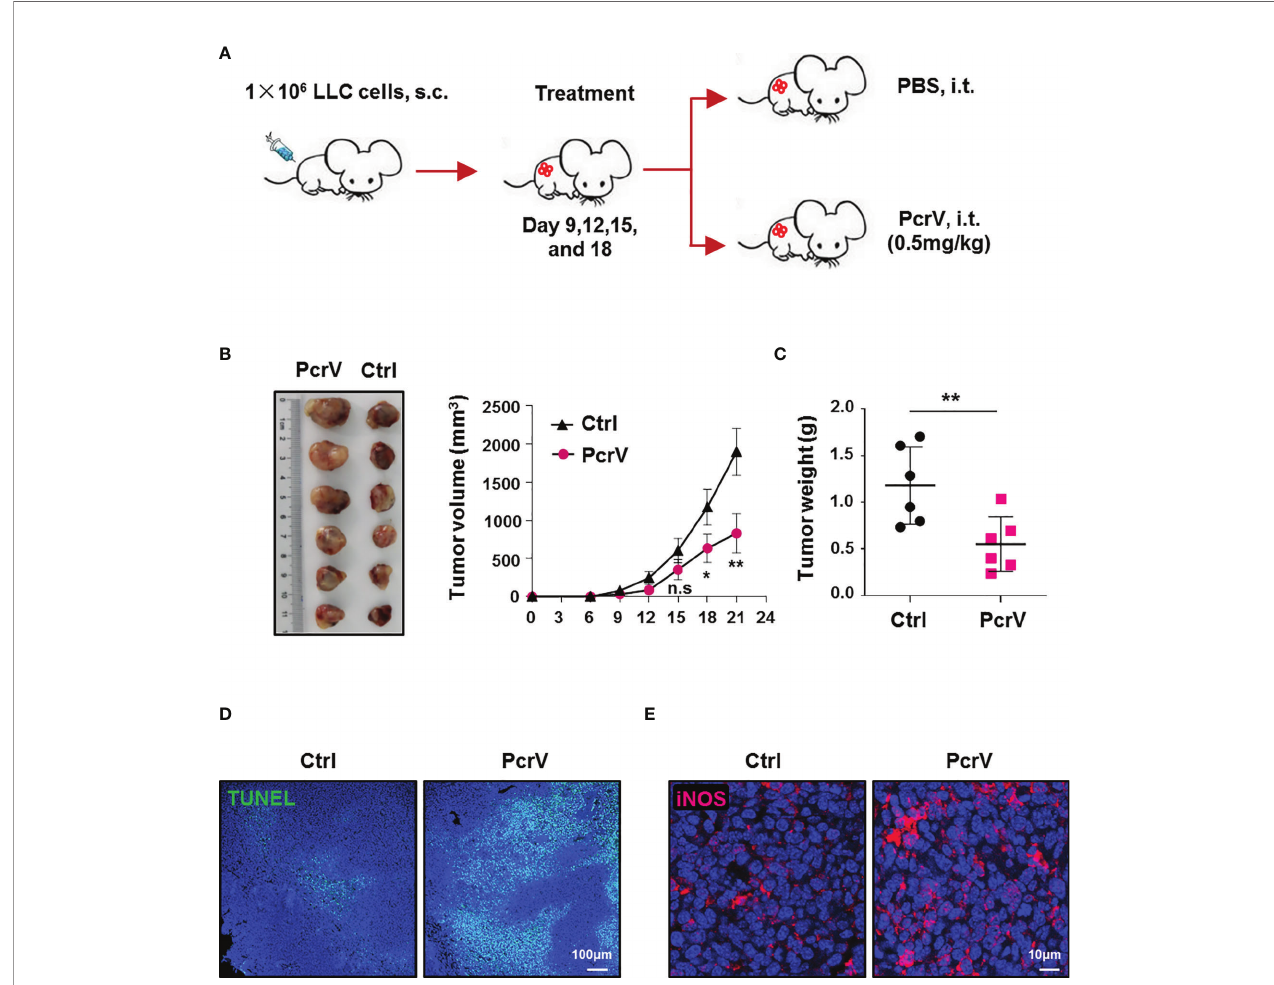
FIGURE 1 | PcrV-mediated suppression of tumor growth is associated with the increased levels of apoptosis and iNOS expression in tumor tissues. Mice bearing LLC cell-derived tumors were treated with PBS or PcrV. (A) Schematic of mouse models used. Tumor growth (B) and weight (C) were measured in LLC tumor- bearing mice treated with PBS or PcrV. Apoptosis (D) and iNOS protein level (E) in tumor tissues were detected by TUNEL assay and immuno fl uorescence staining, respectively. Data were expressed as means ± SEM ( B , n = 6) or means ± SD (C, n = 6) and were analyzed by two-way ANOVA (B) or unpaired Student ’ s t-test (C) . * p < 0.05; ** p < 0.01. n.s, no signi fi cance; s.c, subcutaneous injection; i.t., intratumoral injection; iNOS, inducible nitric oxide synthase; LLC, Lewis lung cancer; PBS, phosphate-buffered